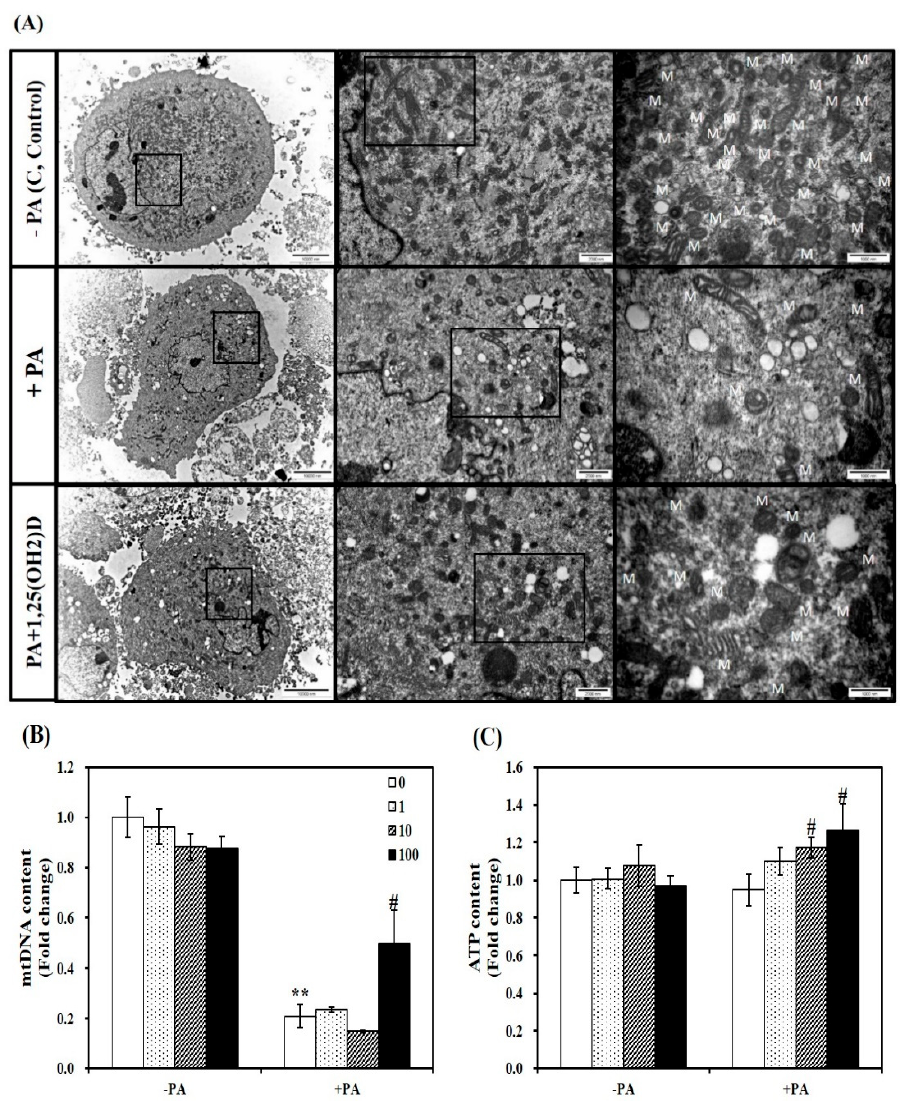
Figure 7. Effect of 1,25-dihydroxyvitamin D (1,25(OH)2D) on fatty acid-induced changes in mitochondrial morphology, mitochondrial DNA (mtDNA) contents, and ATP levels in C2C12 muscle cells. ( A ) Transmission electron microscopy of myotubes (magnification of 7000, 20,000, and 50,000; scale bars = 10, 2, and 1 µ m). M indicates the position of mitochondria. qRT-PCR was used to measure mtDNA transcripts ( B ). ATP concentrations were measured using a colorimetric ATP assay kit, normalized to their relative protein levels, and expressed as the fold change compared to the vehicle control ( C ). Values are expressed as mean ± SEM from at least two or three independent experiments ( n = 6–8 per group). ** p < 0.01 compared to vehicle control. # p < 0.05 compared to PA control. C, vehicle-treated C2C12 muscle cells; PA, 0.5 mM palmitic acid-treated myotubes; PA + 1,25(OH)2D, pretreatment with 0.5 mM PA following 1,25(OH)2D incubation (100 nM, 24 h).